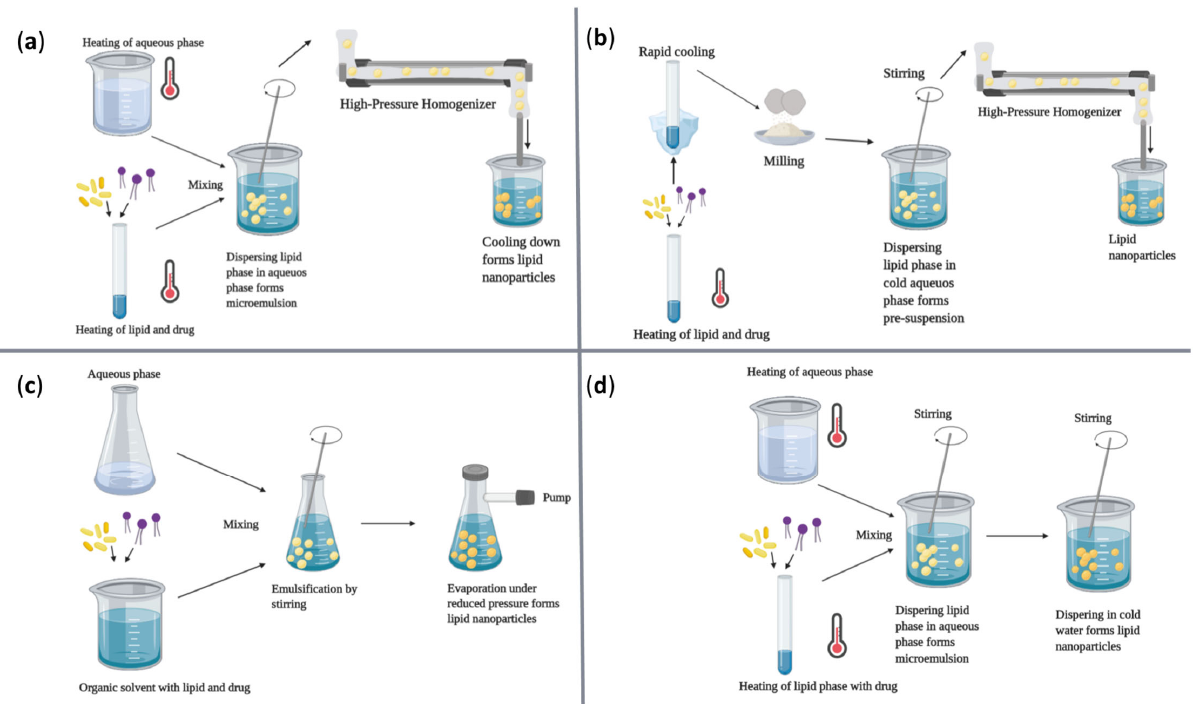
Figure 5. Schematic representation of commonly used synthesis methods to produce lipid-based NPs: ( a ) hot high-pressure homogenization method; ( b ) cold high-pressure homogenization method; ( c ) sol- vent evaporation method; ( d ) microemulsion method. Reprinted from an open-access source [52], adapted from